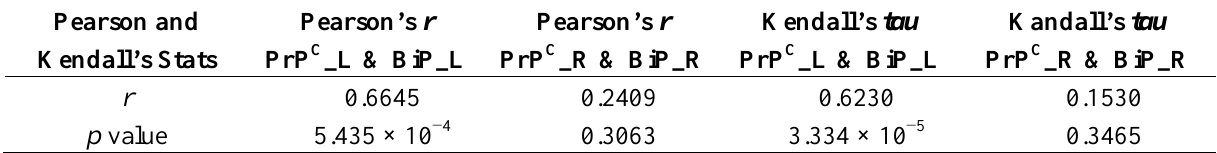
Table 3. Correlation tests using Pearson’s r statistic for transformed data and Kendall’s tau for original